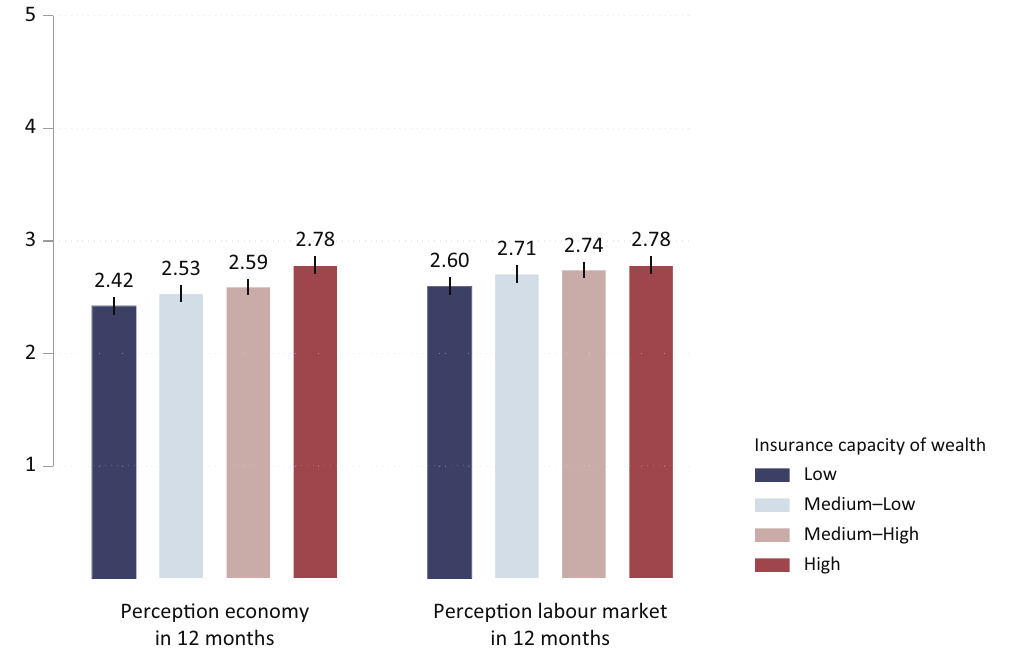
Figure 3. Average dispositional optimism towards the future Italian economy and labour market in 12 months, by insurance capacity of wealth (N = 11,350). Source: Authors’ work based on Bank of Italy (2022). Social Inclusion, 2023, Volume 11, Issue 1, Pages